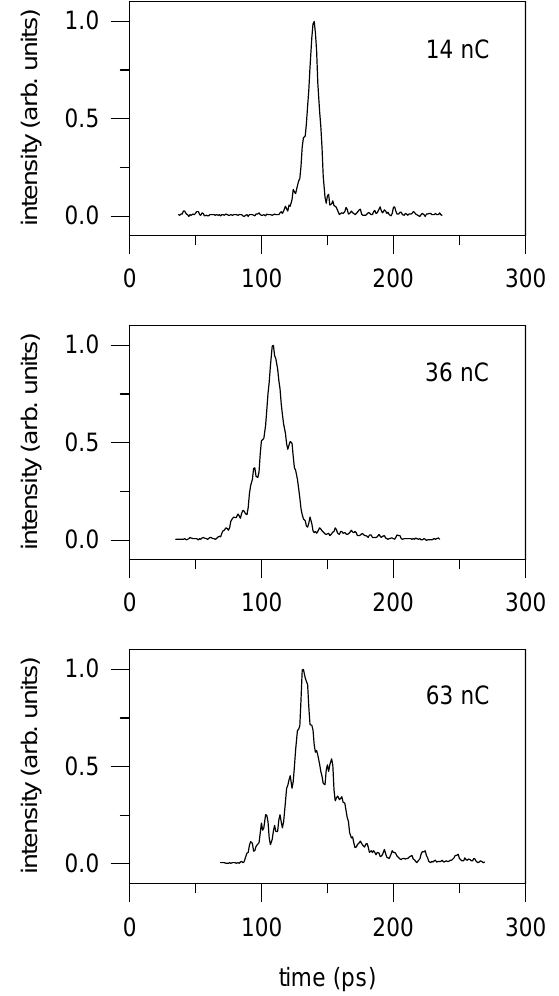
FIG. 4. Longitudinal beam profile for various bunch charges, as measured with a streak camera. The origin of the time scale is arbitrary.